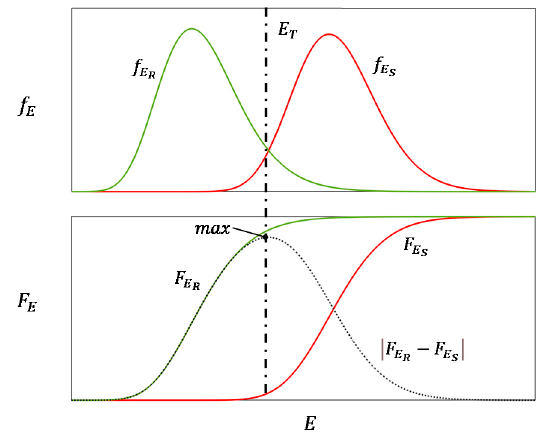
Figure 2. Illustration of the criterium used to select the threshold value E T .